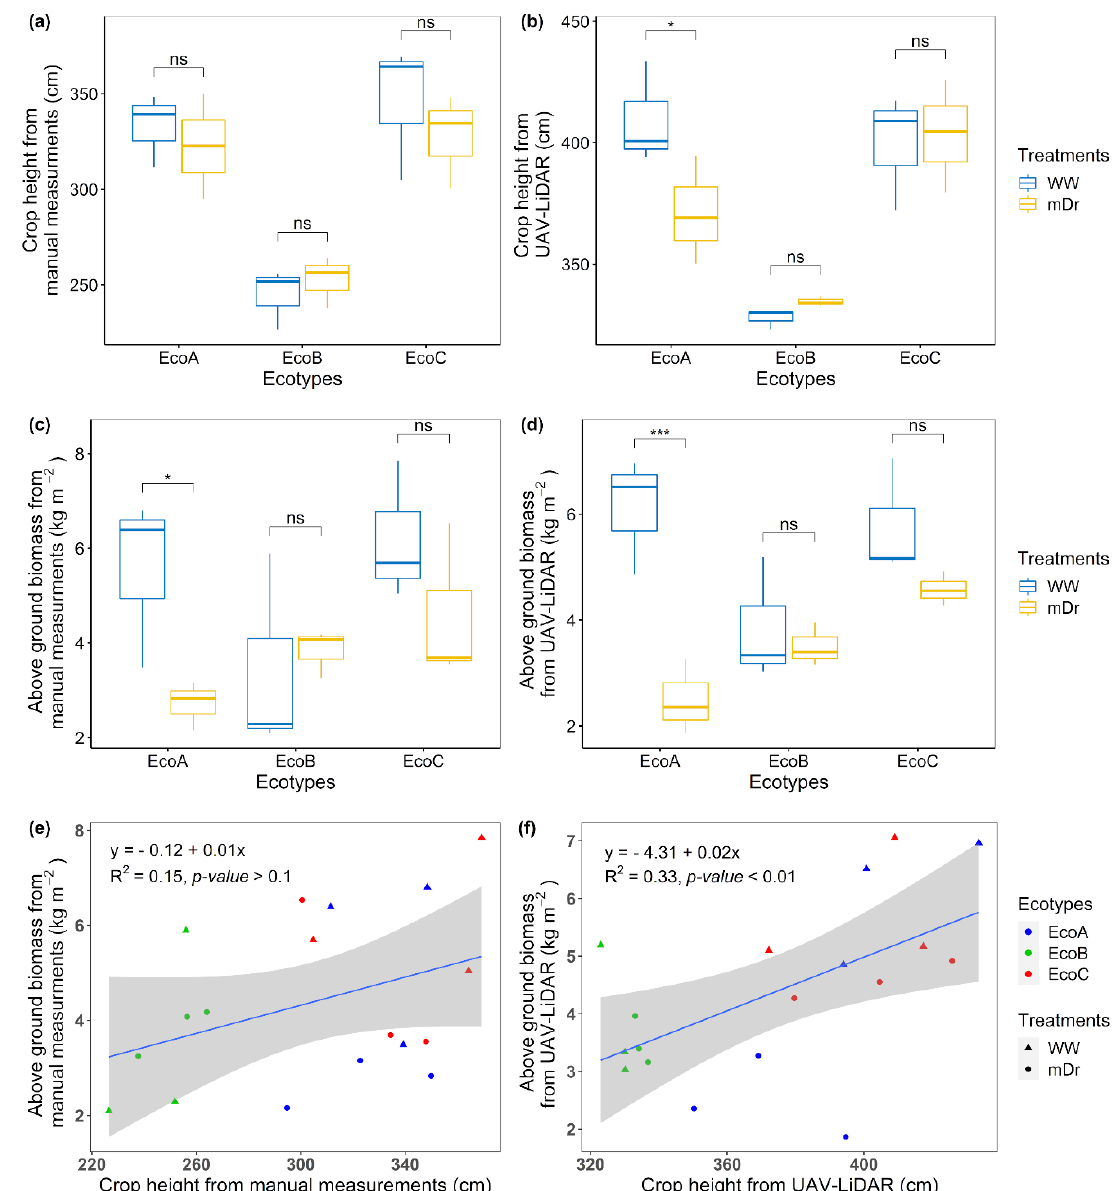
Figure 9. Crop height and above-ground biomass (AGB) of Arundo donax as estimated form manual ground measurements and light detection and ranging (LiDAR) under two water regimes: well-watered (WW) and natural moderate drought (mDr). ( a ) Crop height from manual measurements for EcoA, EcoB, and EcoC. ( b ) Crop height estimated from LiDAR point cloud for EcoA, EcoB, and EcoC. ( c ) AGB estimated from manual measurements for EcoA, EcoB, and EcoC. ( d ) AGB estimated from LiDAR